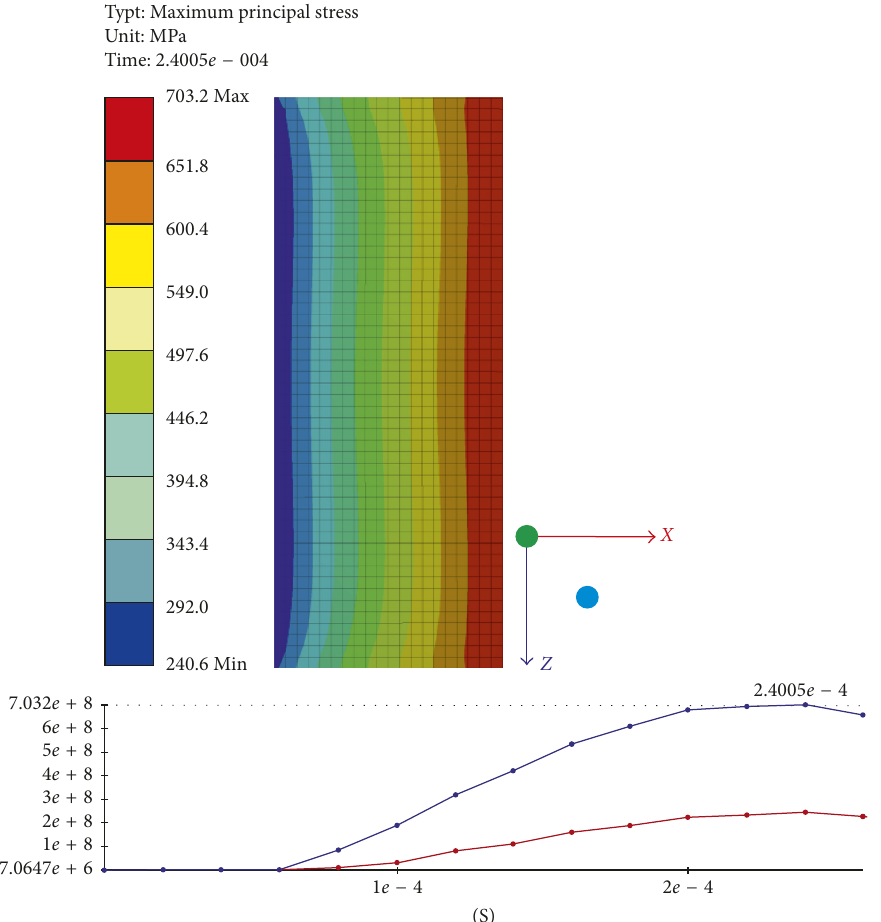
Figure 11: Distribution of Max Principal Stresses in the joint of a block sample (distance from the impactor’s edge to the bondline equals 0.8mm).